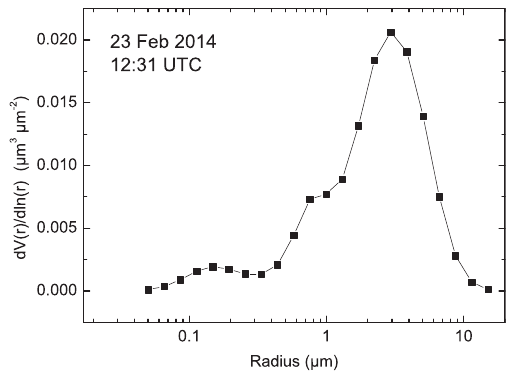
Figure 16. AERONET particle volume size distribution for 23 February 2014, 12:31UTC, at Ragged Point, version 1.5 (Holben et al., 1998; AERONET,